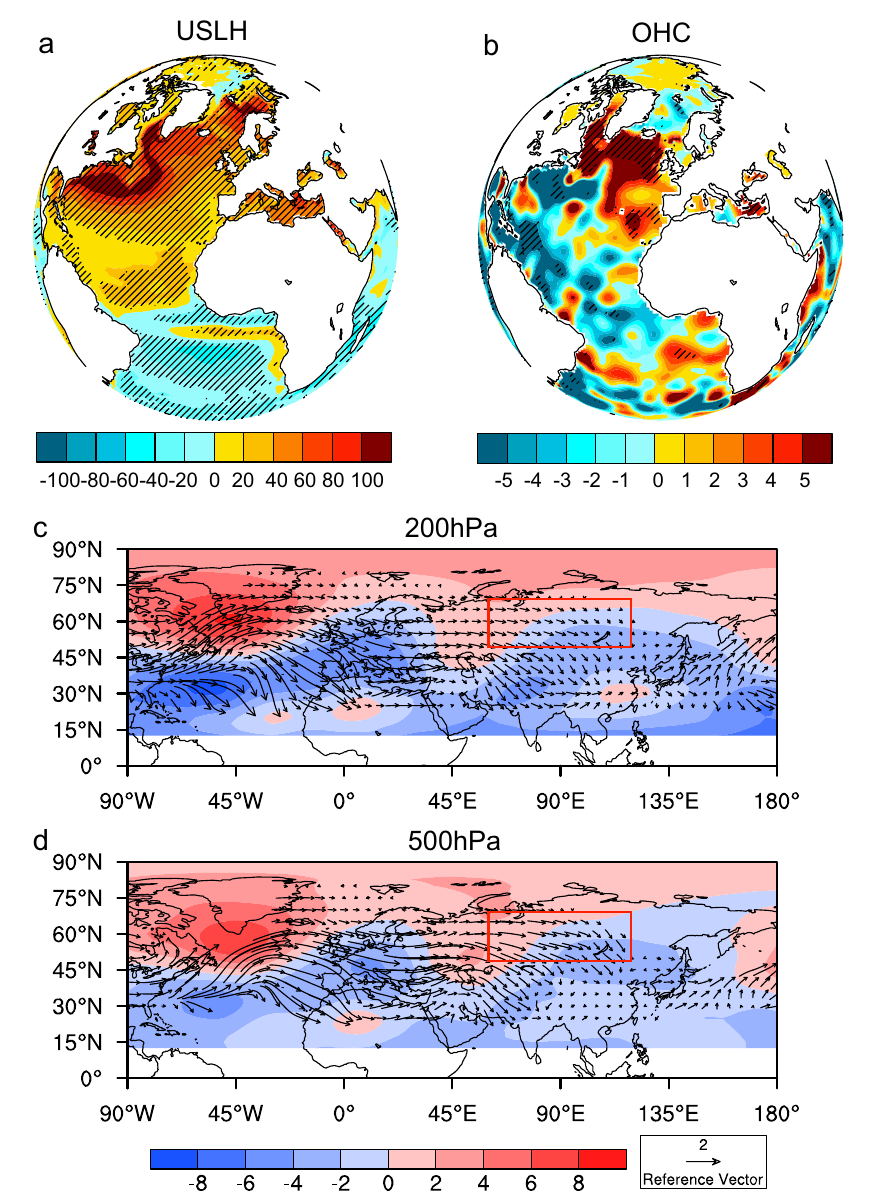
Fig. 4 Differences in the sea-air heat exchange and ocean heat transmission in winter between the strong and weak AMOC phases. Difference in the a USLH (shadings, units: W·m -2 , based on the WHOI dataset), b 0 – 700 m OHC (shadings, units: 10 18 joules, based on the NECI dataset) and stream functions (shadings, units: m 2 ·s − 1 ) and wave activity fl uxes (vectors, units: m 2 ·s -2 ) at 200 hPa ( c ) and 500 hPa ( d ) based on the NECP datasets in winter between the strong and weak AMOC phases. Hatched areas in a and b indicate signi fi cance at the 95% con fi dence level using Student ’ s t test for USLH and OHC, respectively. The red boxes in c and d are the Siberia